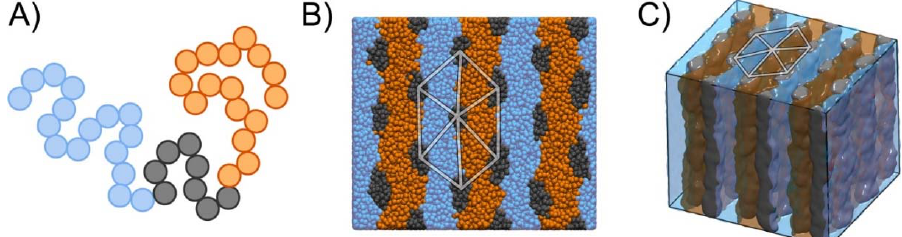
Table 2. Interaction parameters for the S ‐ M, S ‐ B, and B ‐ M particle pairs. Interaction pairs Figure 2. Dissipative particle dynamics (DPD) simulations of an SBM triblock terpolymer melt. ( A ) Schematic representation of the SBM triblock terpolymer used in the DPD simulations. The S,